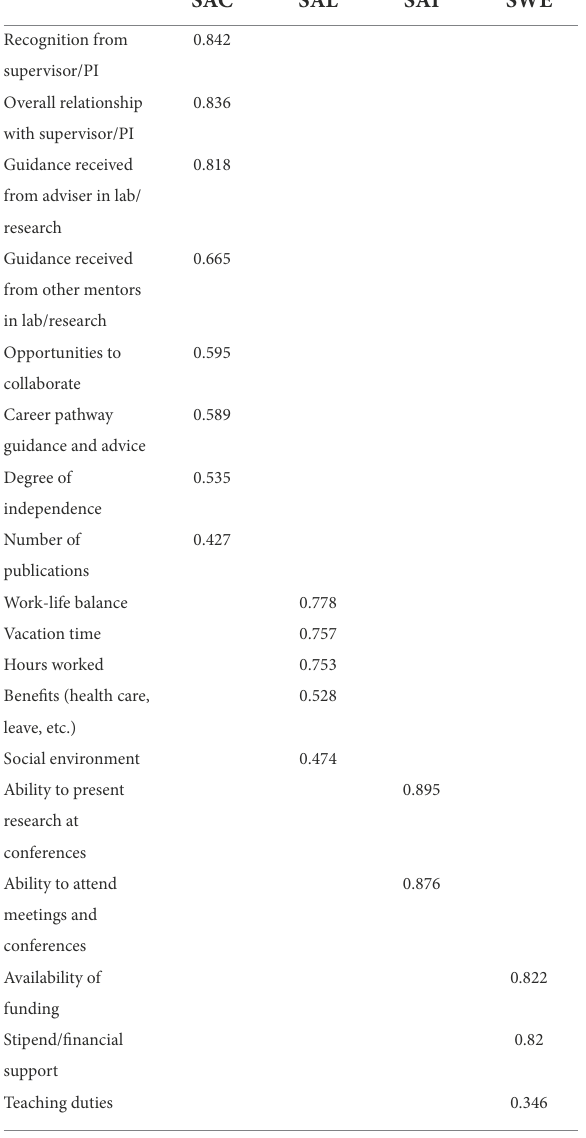
TABLE 1 Results of exploratory factor